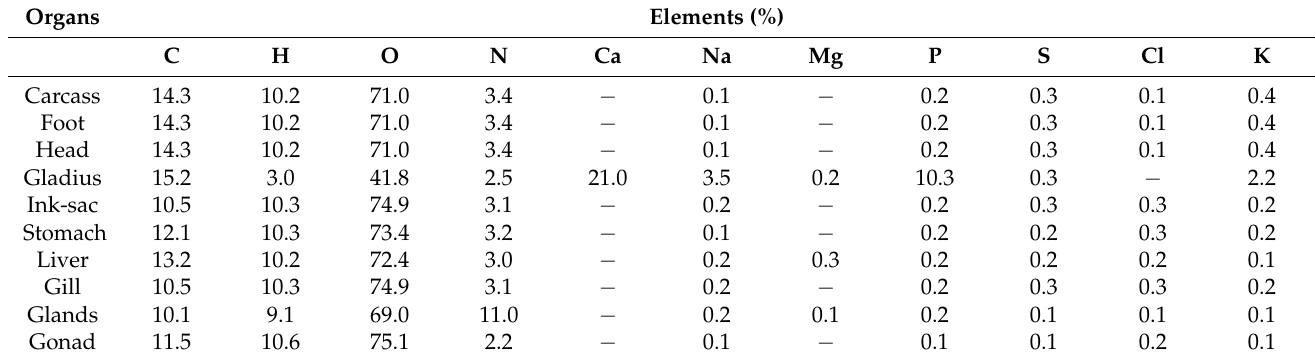
Table 1. Elemental composition of the organs in the O. bartramii sample [31].